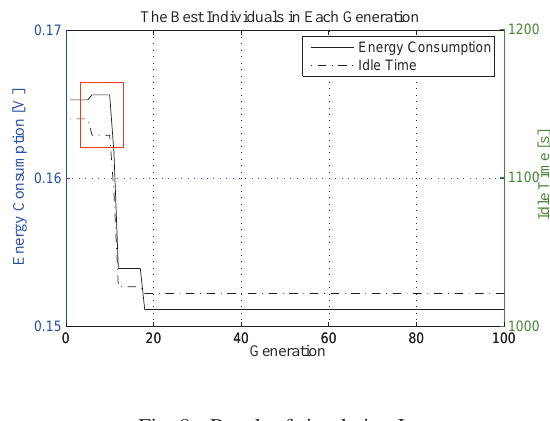
Fig. 8. Result of simulation